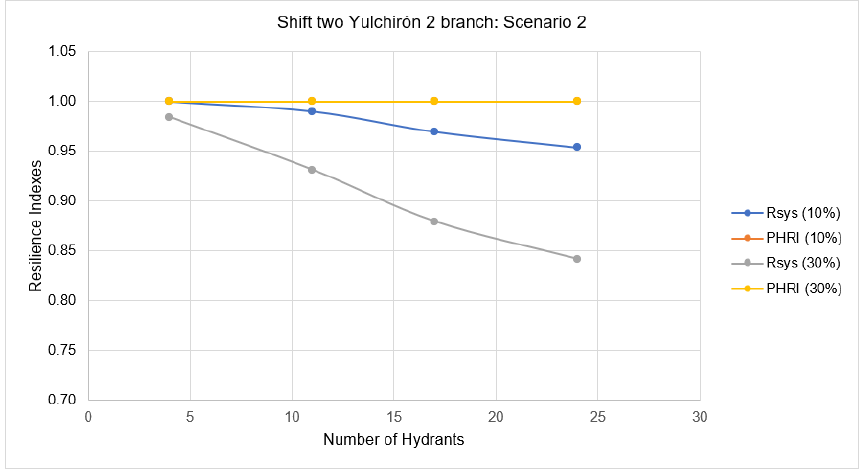
Figure 17. “Rsys” and “PHRI” results, for scenario 2 in shifts.